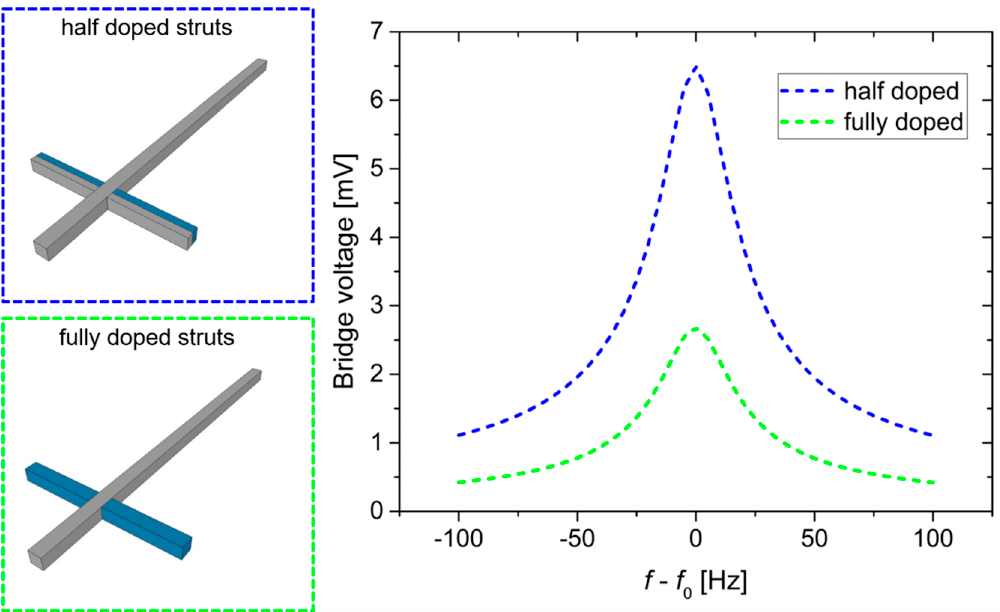
Figure 7. Electro-mechanical simulation of the cantilever structure with half-doped and fully doped struts.